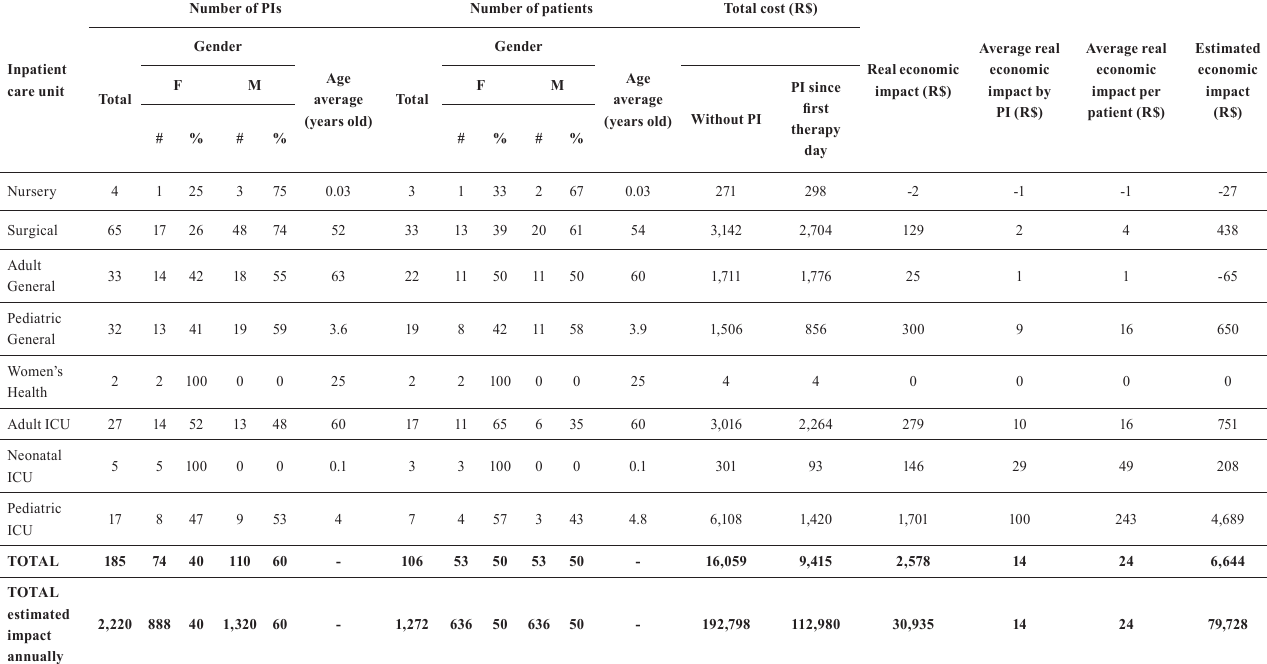
TABLE III - Characterization of the pharmaceutical interventions and economic impact analysis by inpatient care unit